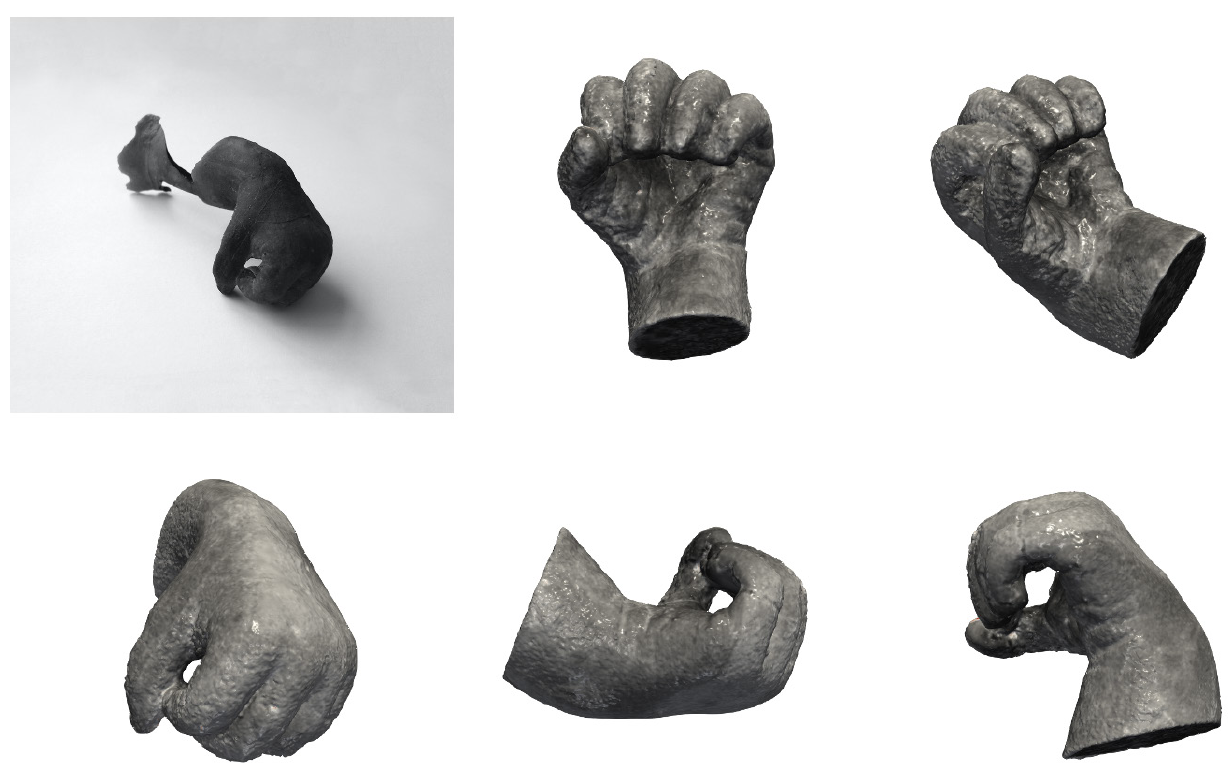
Figure 7: ‘PEDM’ by Alastair Mackie. Top-left: the original piece (as shown in Figure 1E). The other panels show different rotations of the 3D model of the object created using photogrammetry (see text for details). The diameter of the base of the wrist section is 5